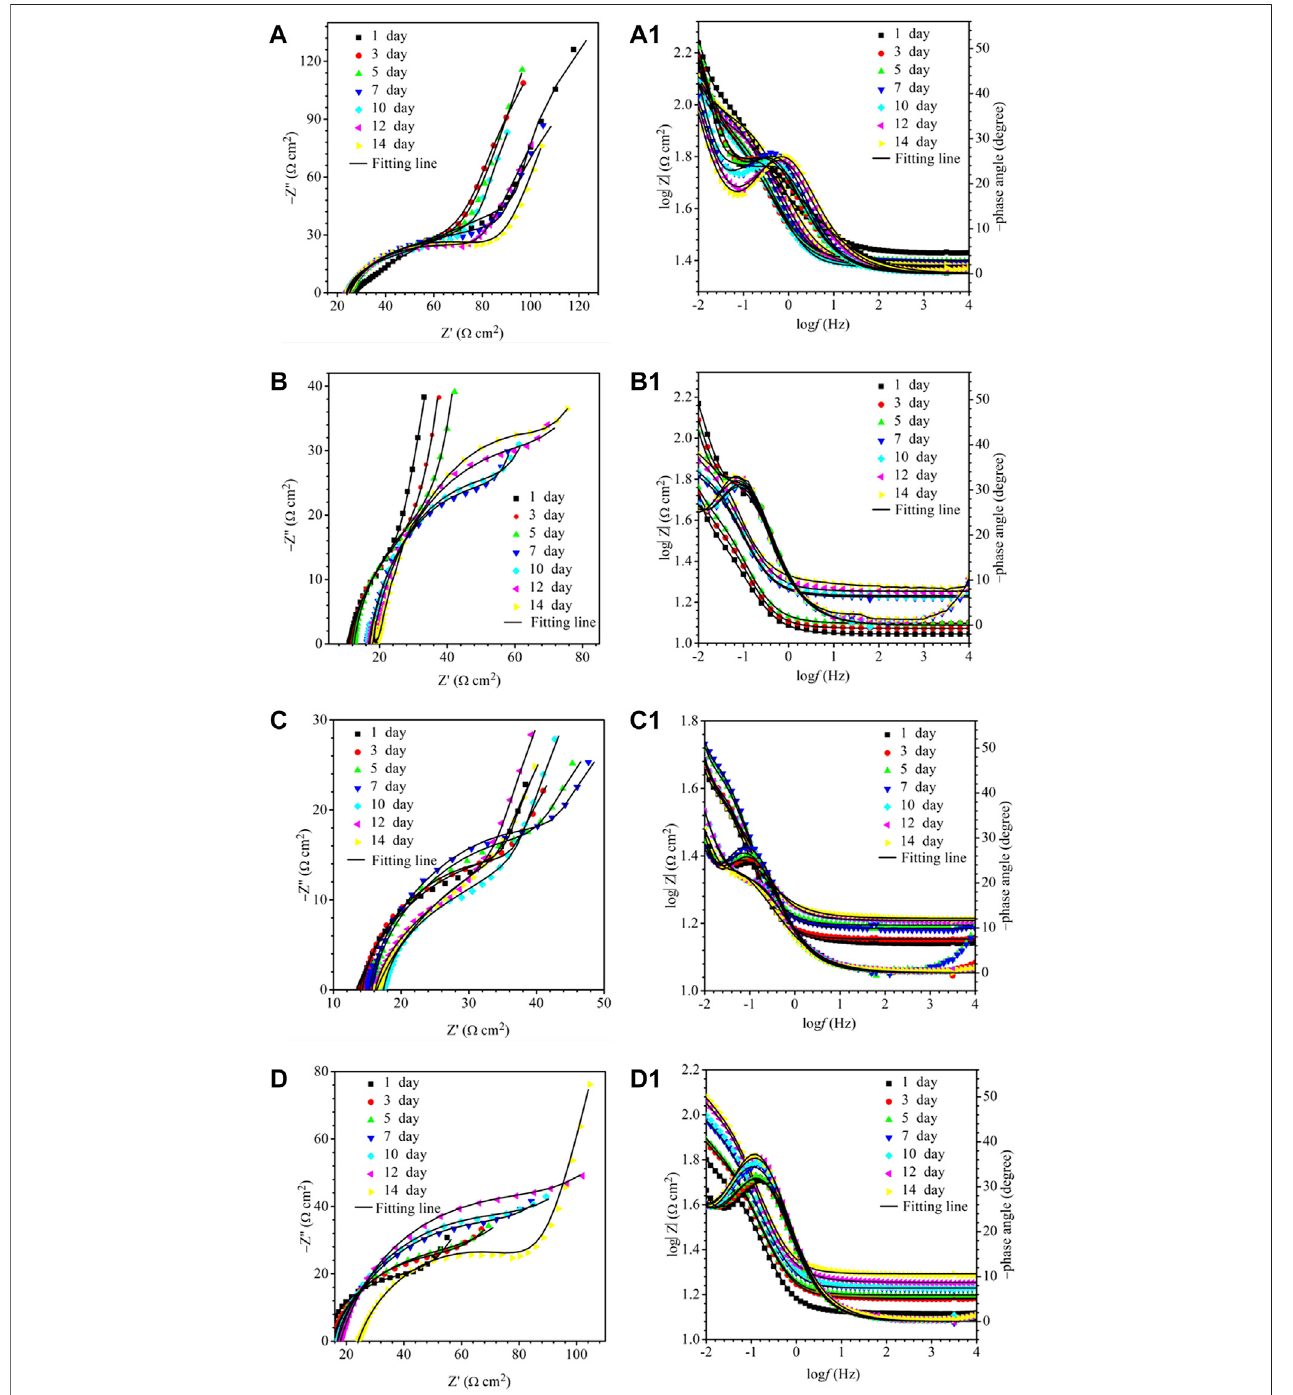
FIGURE 7 | Nyquist and Bode plots for X80 during 14-days incubation in an anaerobic vial with 200 ml of D. vulgaris broth, 250 ml of headspace, and carbon source levels of 0% (a,a1) , 10% (b,b1) , 50% (c,c1) , and 100% (d,d1) . day carbon starvation incubation. The amount of sessile cells on their surfaces were increasing with increasing carbon source The SEM images in Figure 3 depict the surface morphologies of level as expected. The SEM images in Figure 4 are consistent the D. vulgaris bio fi lms under different carbon sources after 14-